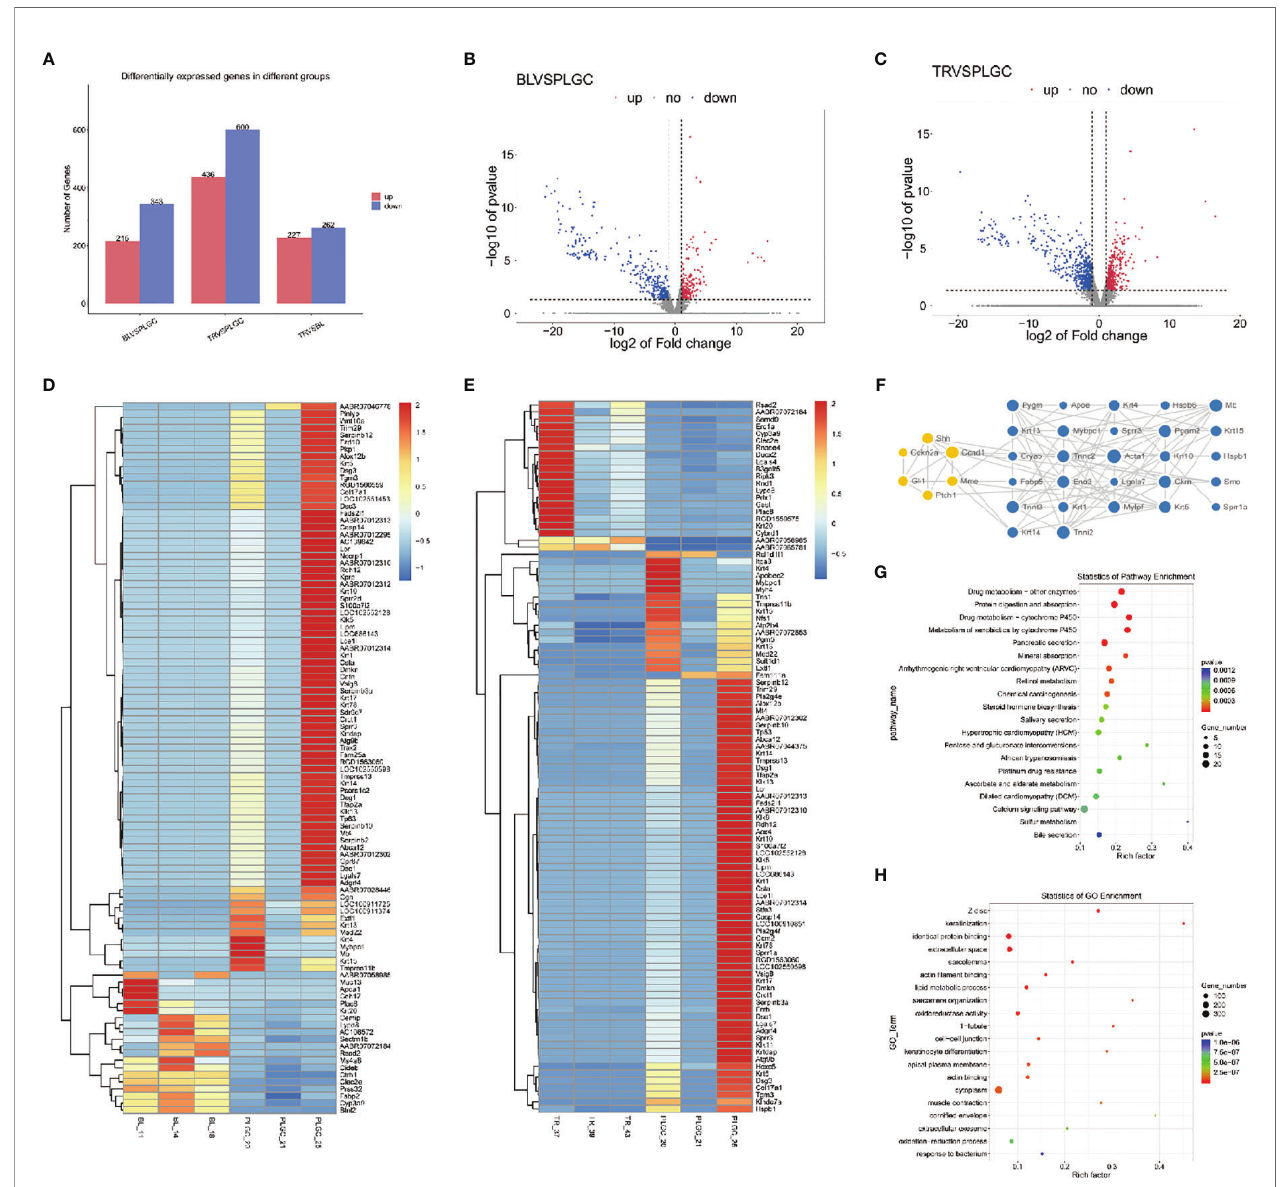
FIGURE 8 | Differential gene expression. (A) Statistics of upregulated and downregulated differentially expressed genes in each group. (B) Distribution of upregulated and downregulated differentially expressed genes in the blank group and model group. (C) Distribution of upregulated and downregulated differentially expressed genes between the treatment group and the model group. (D) Heat map was used to show the gene expression in the blank group and model group. (E) Heat map was used to show the gene expression in the treatment group and model group. (F) Interaction network constructed by 33 genes. (G) Make KEGG enrichment analysis scatter diagram according to the signi fi cance of enrichment. (H) Make GO enrichment analysis scatter diagram according to the signi fi cance of